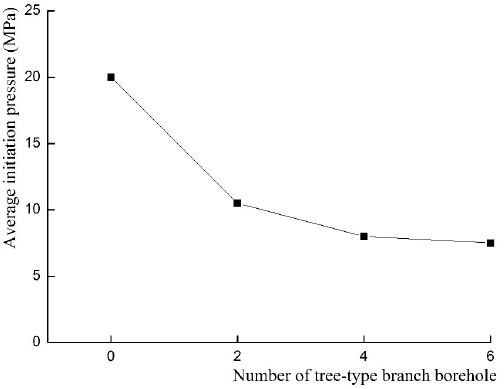
Figure 4. Average initiation pressures as a function of the number of branches in the tree-type borehole arrays in numerical simulation.